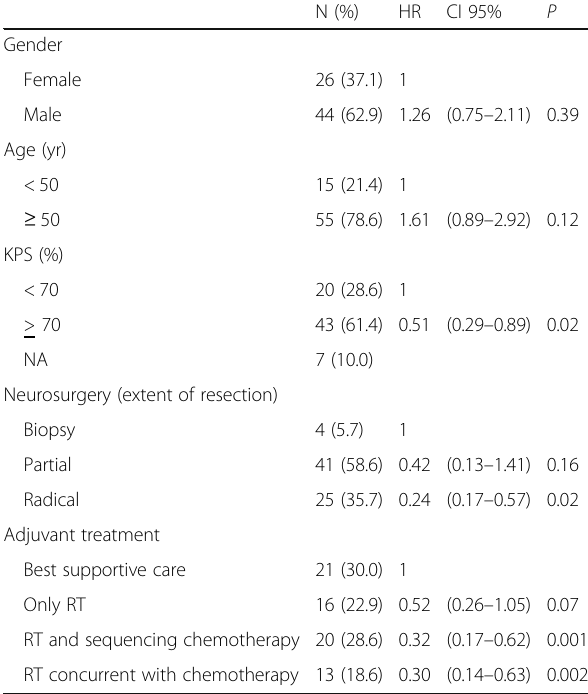
Table 2 Demographics, clinical and treatment data of GBM patients (univariate analyses)